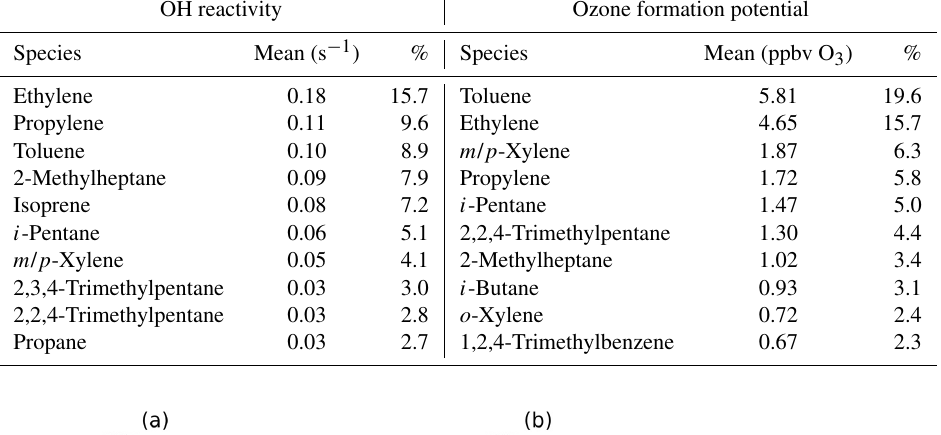
Table 5. Top 10 VOC species (mean and percentage breakdown) which contribute to ozone formation based on OH reactivity and ozone formation potential during ARIAs.